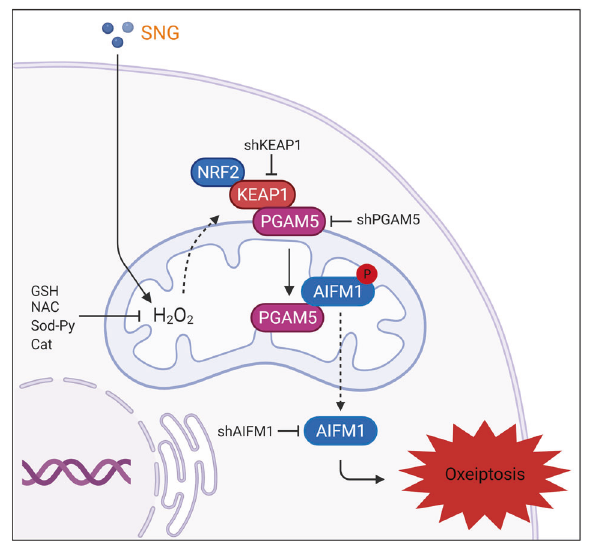
Fig. 8 Summary diagram. Schematic diagram of the pathway in which SNG induces oxeiptosis in human colorectal cancer